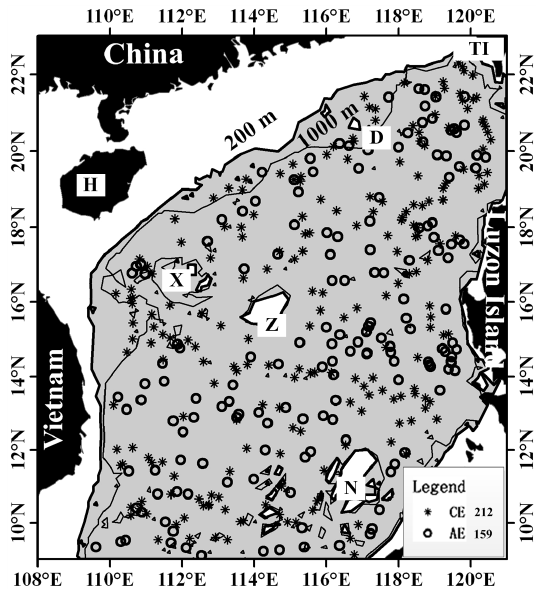
Fig. 6 Fig. 1. Map of study area. Birth locations of cyclonic and anticy- clonic eddies are symbolized by the asterisk and circle, respectively, and the numbers of them are showed in the legend. Black solid lines indicate 200-m (bold) and 1000-m (thin) isobaths. Some geographic names are represented by initials. H = Hainan Island; TI = Taiwan Island; D = Dongsha Islands; X = Xisha Islands; Z = Zhongsha Is- lands; N = Nansha